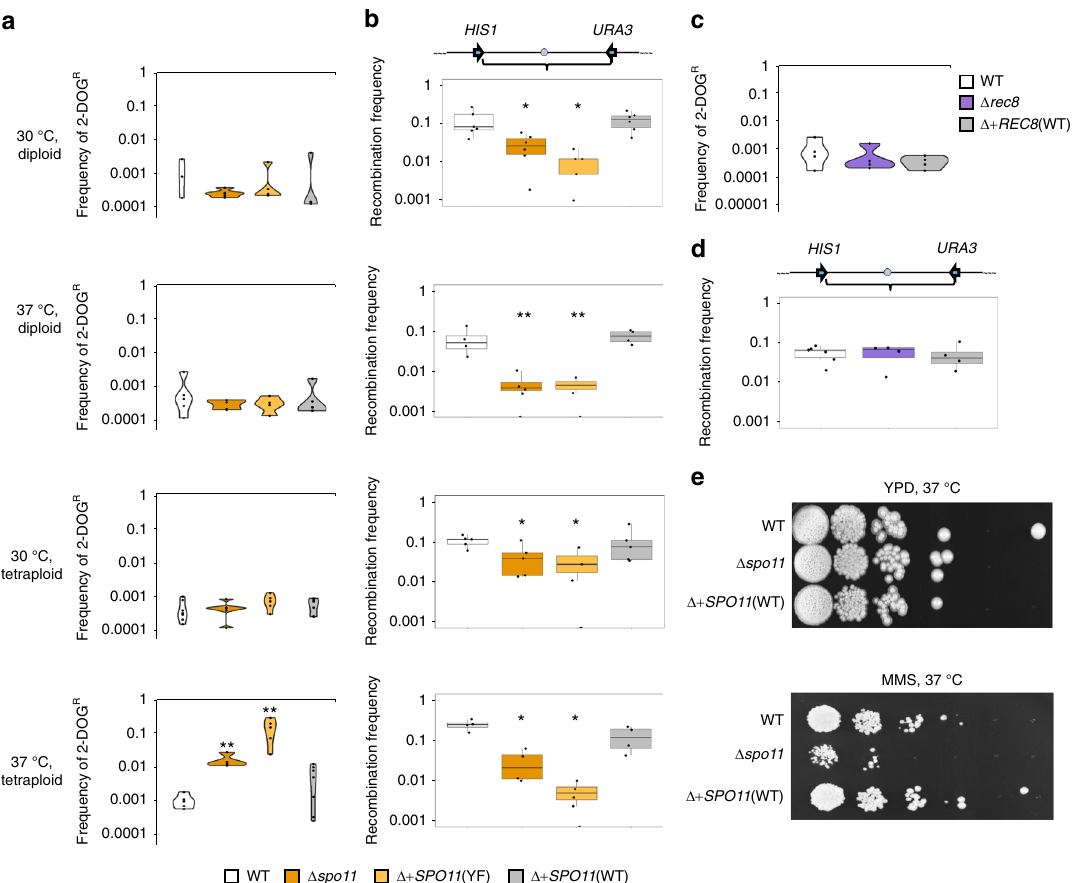
Fig. 4 Spo11, but not Rec8, promotes recombination in mitotically dividing C. albicans cells. a – d Genetically marked diploid and tetraploid C. albicans strains were serially passaged in YPD medium at 30 °C or 37 °C (cells diluted 1:100 every 24 h), and evaluated for loss of the GAL1 marker (2-DOG R frequency) and for the frequency of recombination in the HIS1-URA3 interval. a Frequency of 2-DOG R colonies in diploid/tetraploid wildtype and SPO11 mutant strains . n = 4, 5, 6, and 6 biologically independent experiments for 30 o C diploid, 37 o C diploid, 30 o C tetraploid, and 37 o C tetraploid, respectively. b Frequency of recombination between HIS1 and URA3 on Chr1 in diploid/tetraploid wildtype and SPO11 mutant strains. n = 4, 4, 5, and 5 biologically independent experiments for 30 o C diploid, 37 o C diploid, 30 o C tetraploid, and 37 o C tetraploid, respectively. c Frequency of 2-DOG R colonies in wildtype or REC8 mutant tetraploid strains passaged at 30 o C. n = 4 biologically independent experiments. d Analysis of recombination in the HIS1-URA3 interval for wildtype or REC8 mutant tetraploid strains passaged at 30 o C. n = 4 biologically independent experiments. e Tenfold spot dilution assays performed for wildtype, Δ spo11 , and SPO11- complemented tetraploid cells grown on YPD medium in the presence or absence of 0.01% methyl methanesulfonate (MMS) and imaged after 2 days at 37 o C. * denotes p < 0.05. ** denotes p < 0.01 as calculated by two-sample t (chromosome loss) or Wilcoxon (recombination frequency) tests. Boxplots are presented as the 25th to 75th percentile with the thick line denoting the median. Whiskers indicate the largest and smallest values within 1.5 × of the interquartile range. White, orange, light orange, and gray denote WT, Δ spo11 , Δ + SPO11 (YF), and Δ + SPO11 (WT), respectively. White, purple, and gray denote WT, Δ rec8 , and Δ + REC8 (WT),